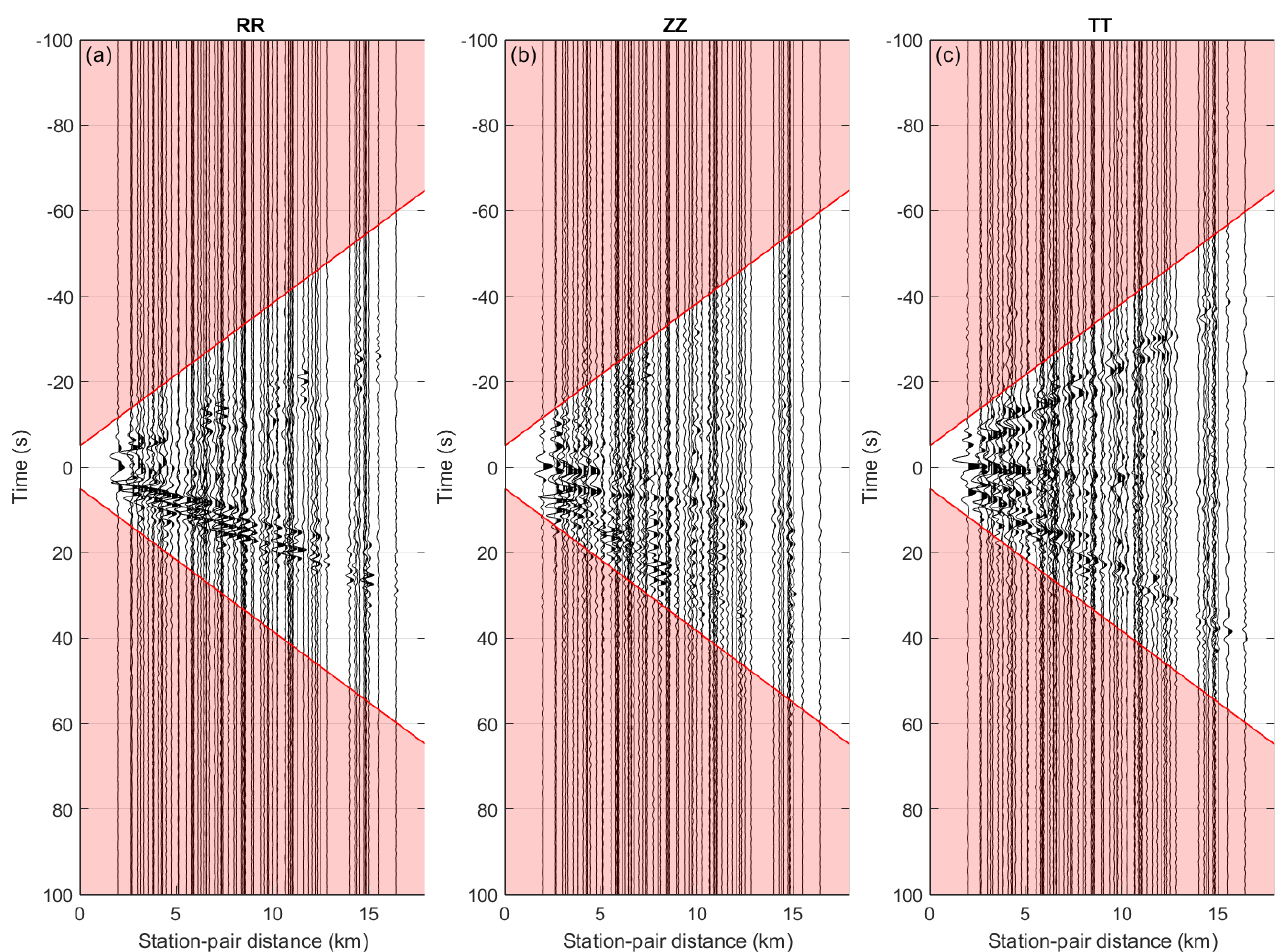
Figure 7. Reference cross-coherence H ref (i.e., average cross-coherence between 1 January 2017 and 31 December 2019) for all combinations of receivers shown in Figure 1 as a function of receiver-pair distance for components ( a ) RR, ( b ) ZZ and ( c ) TT. The red lines indicate the arrival times | t | = x /300 + 5, between which we expect all arrivals of direct surface waves, while the red area indicates the coda time windows ( x /300 + 5 ) s < | t | ≤ 100 s, used in Equation (15) to retrieve relative velocity